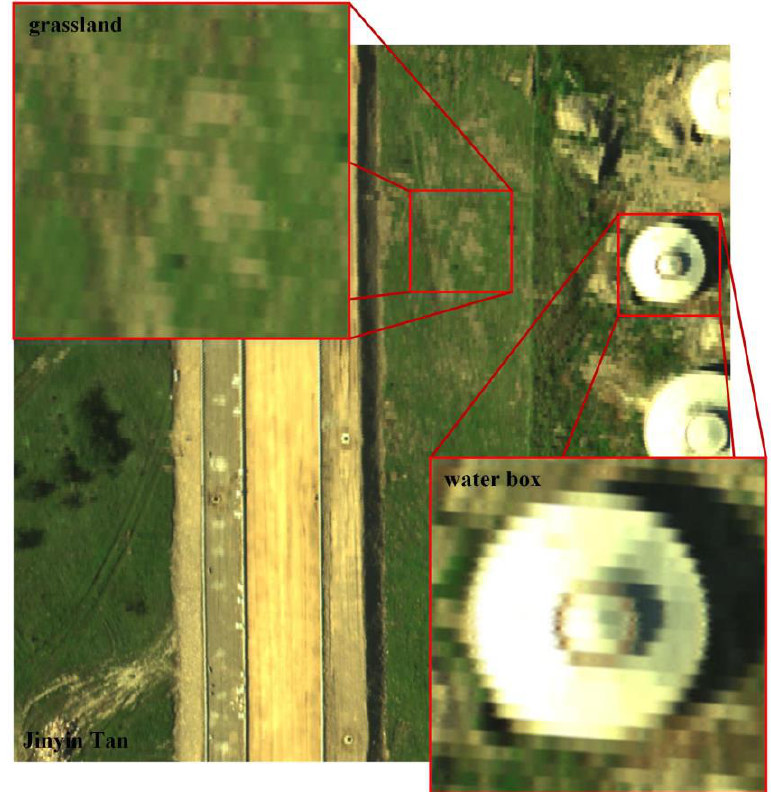
Figure 8. False color image of Jinyin Tan dataset 1 (water box) and Jinyin Tan dataset 2